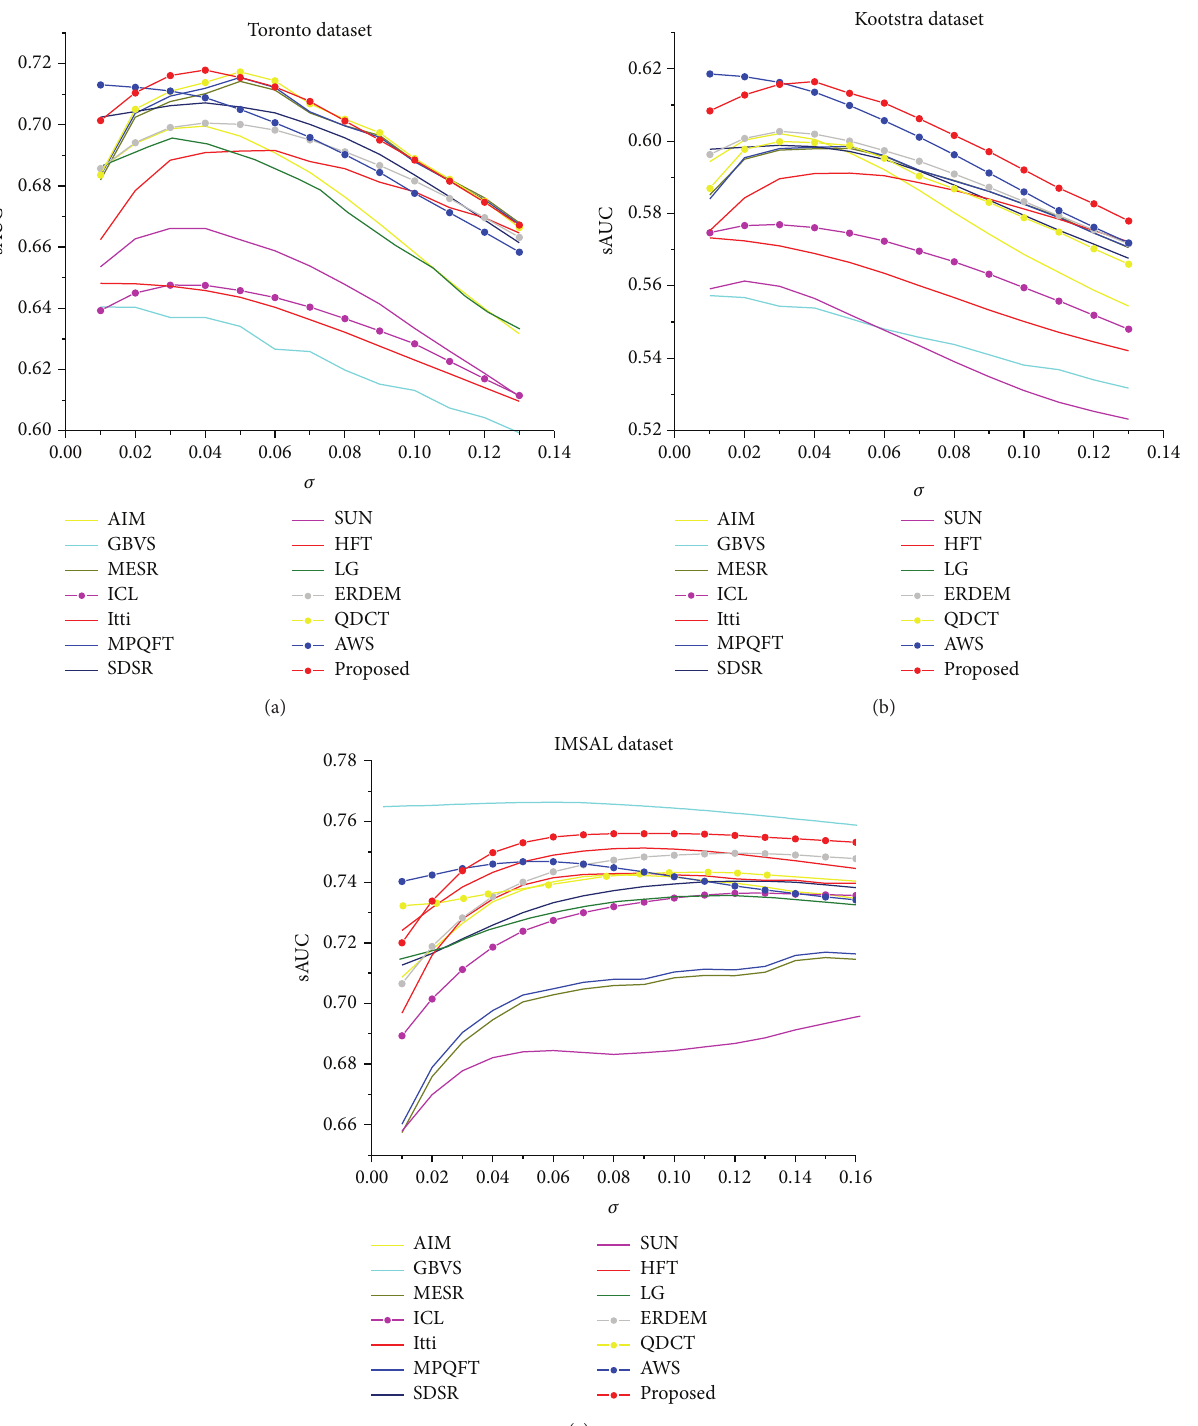
Figure 6: Toronto, Kootstra, and IMSAL datasets with variable Gaussian smoothing for all algorithms in comparison. The 𝑥 -axis represents the 𝜎 of the smoothing Gaussian (in image width). (In (c) only GBVS, LG, and Δ QDCT are taken from